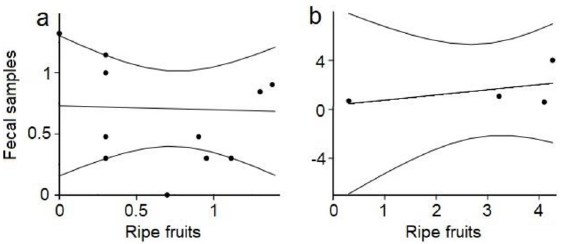
Figure 4. Correlations between the seasonal availability of ripe fruits on the monitored plants and the presence of S. granulosopeprosum seeds in fecal samples of S. lilium . Monthly in left (a) (R = -0.035, R 2 = 0.001, p = 0.913) and per season in right (b) (R = 0.476, R 2 = 0.226, p = 0.523), with 95% of